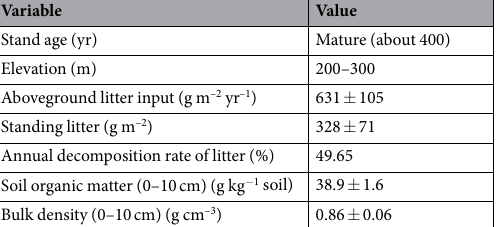
Table 2. Stand characteristics of the old-growth tropical forest in southern China. Values are means ± SE (n =